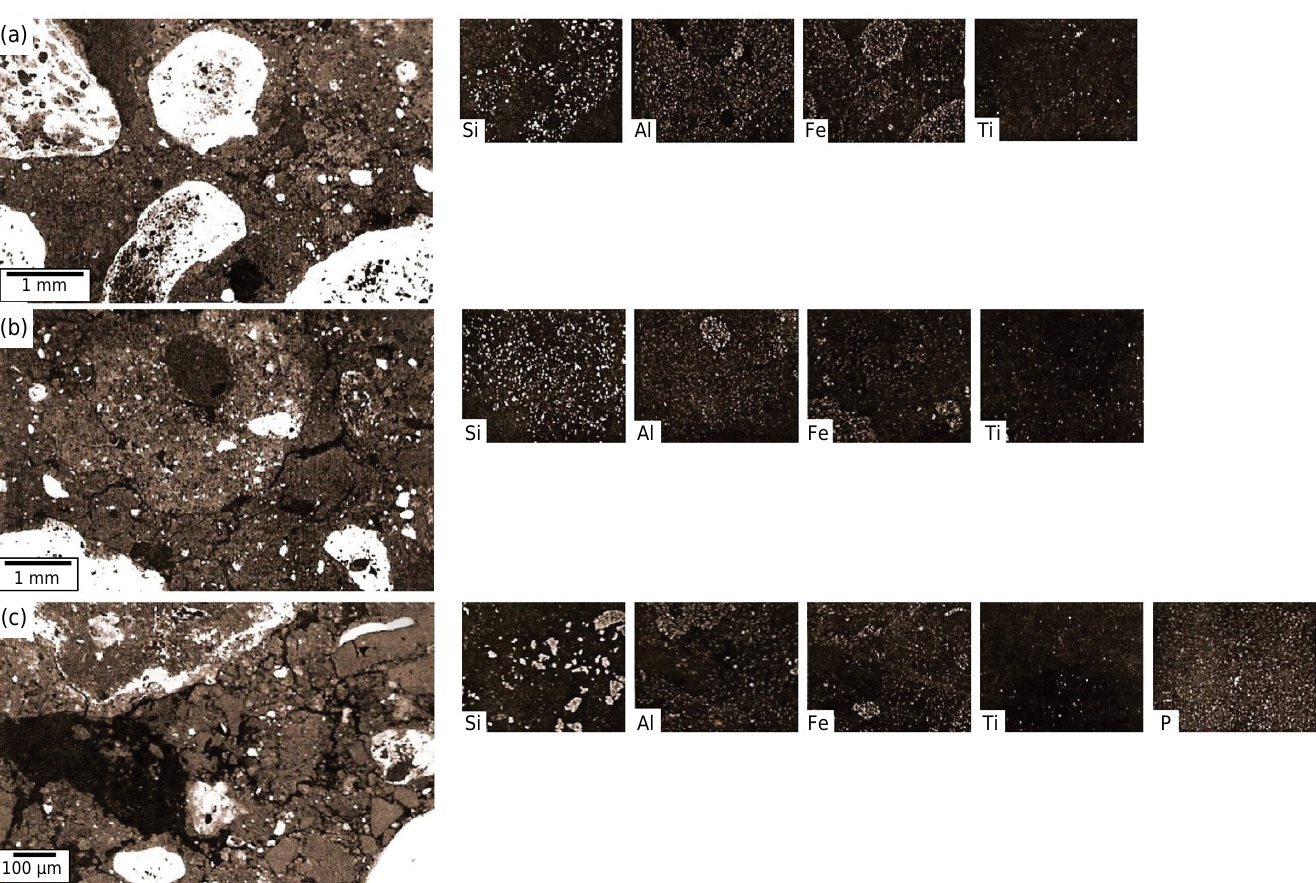
Figure 12. SEM photomicrographs and EDS microchemical maps of the Bw 2 horizon in the P 7 - Geric Rhodic Petroplinthic Ferralsol (Clayic, Dystric); Coromandel topolithosequence. Sand-sized micronodules (a and b), and quartz and P-rich grains (c).